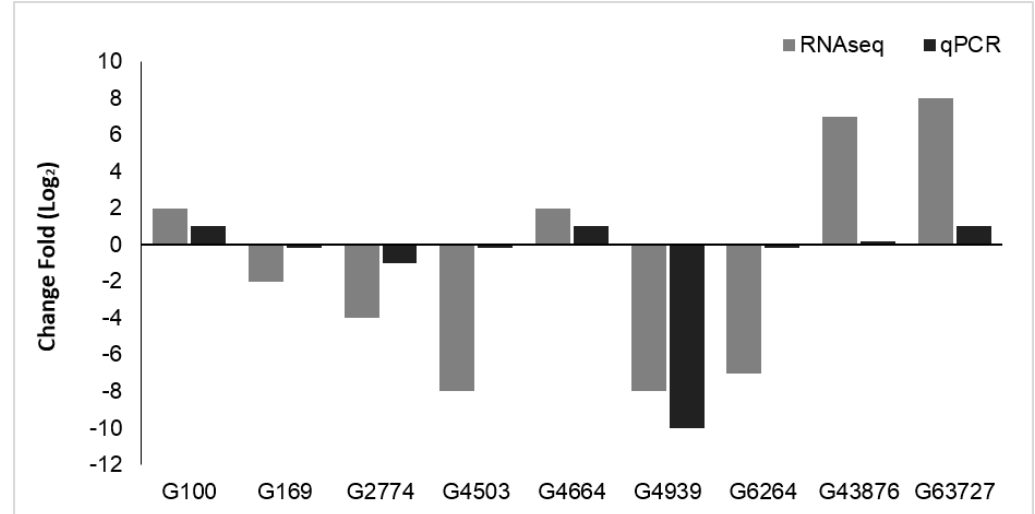
Figure 9. Change fold for each of the transcripts tested for validation. The values are represented as the Log2 of the normalized expression value of both RNA-seq and qPCR data.